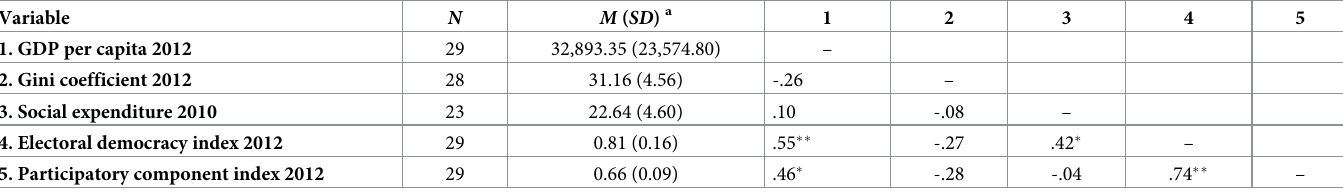
Table 6. Descriptive statistics and correlations for the country-level predictors (Study